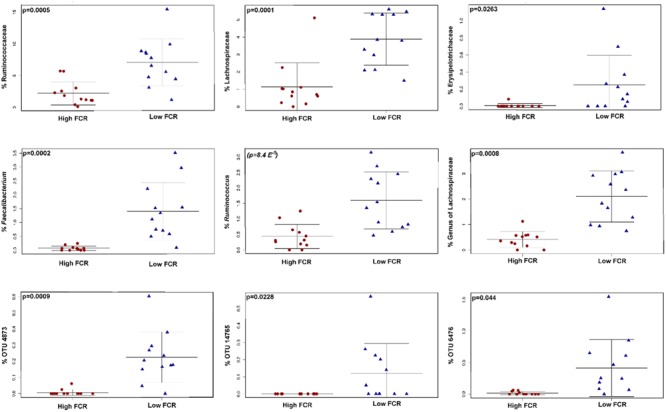
The taxa responsible for differences in high and low FCR cecal communities in Trial 1. The figure shows family (top row), genus (middle row) and OTU level (bottom row). A table with all differentially abundant phylotypes is given in Supplementary Table S1. The closest cultured strain (EzTaxon database) to OTU 4873 was F. praustnizii [ATCC 27768(T)] with 93.7% pairwise similarity, OTU 14765 was closest to Clostridium spiroforme [DSM 1552(T)] with 99.6% pairwise similarity to the type strain and out 6476 was closest to C. lactatifermentans (89.76%).